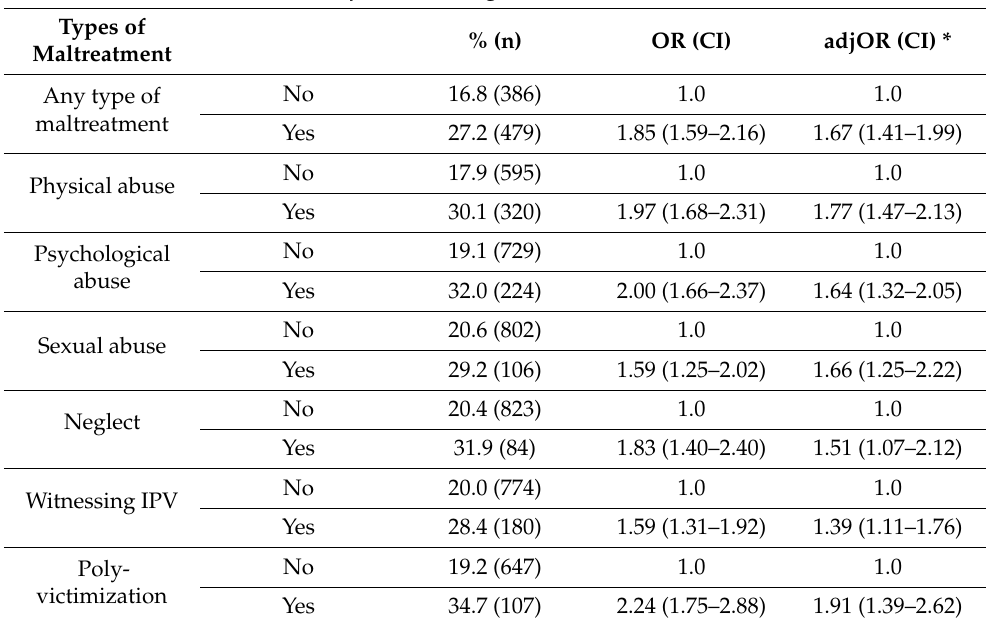
Table 3. The association between different types of child maltreatment (during life) and self-reported unintentional injuries leading to health- or dental care in the last